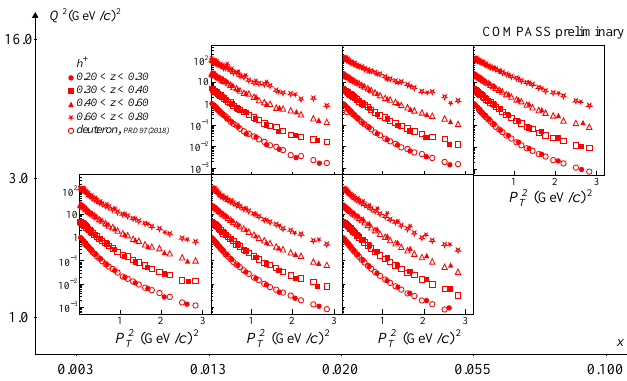
Figure 3: P 2 —distributions for positive hadrons in four z bins and in bins of x and T Q 2 , for the new preliminary results on proton (full markers) and for the published deuteron results (empty markers) [ 7 ]